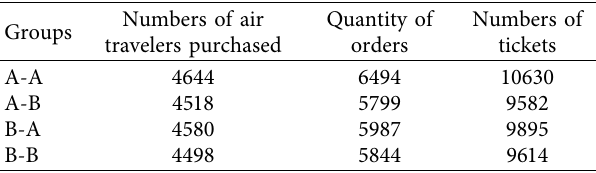
Table 3: The data of “89 promotions” campaign.